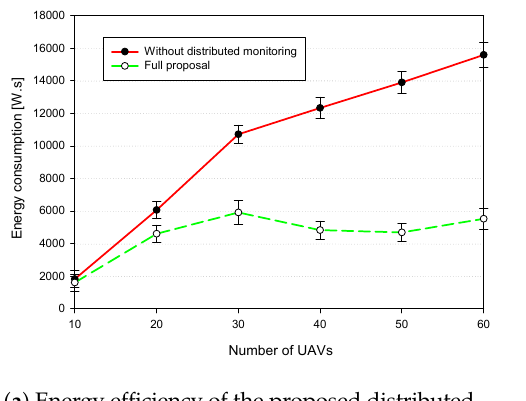
( a ) Energy efficiency of the proposed distributed monitoring technique. Figure 11. Generated overhead and energy efficiency our